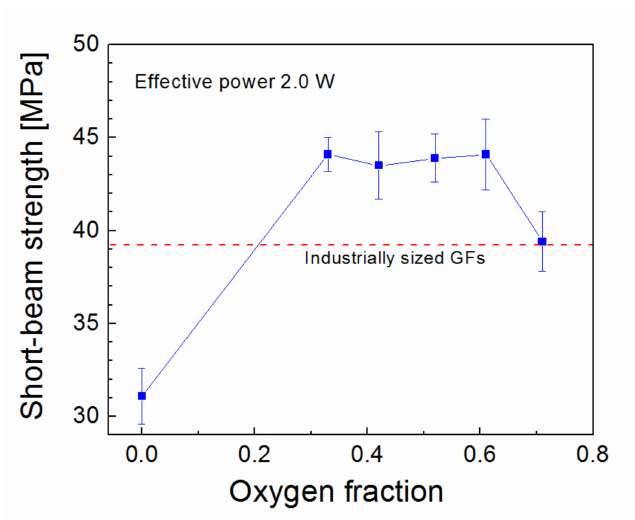
Figure 14. Short-beam strength of GF / polyester composites dependent on oxygen fraction in TVS / O 2 mixture used for plasma-coated GFs compared to the shear strength corresponding to industrially sized GFs.